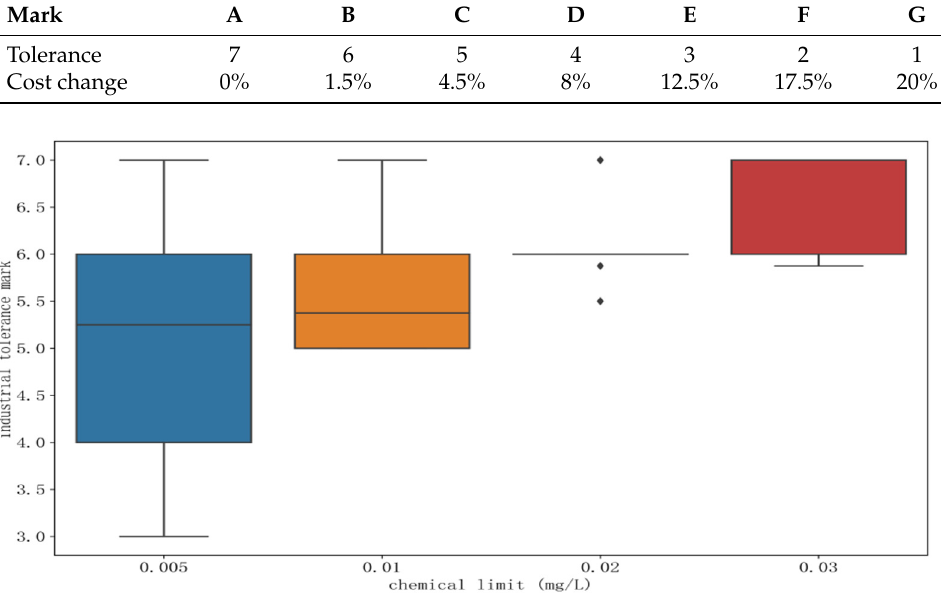
Figure 6. Relation between the industrial tolerance mark and chemical